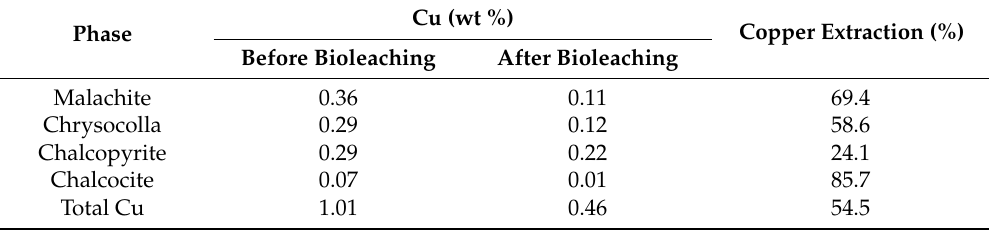
Table 2. Phase composition of copper ore before and after bioleaching at the pulp density of 1% and copper extraction (%) after 156